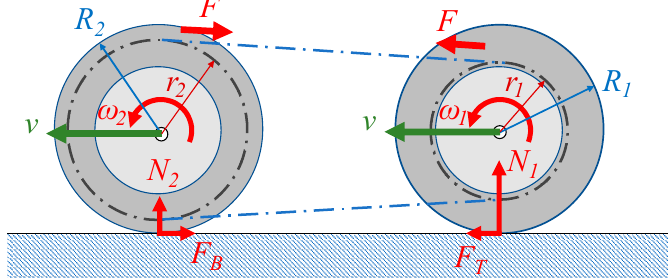
Figure 7. Mechanical properties between two tires [19,20].